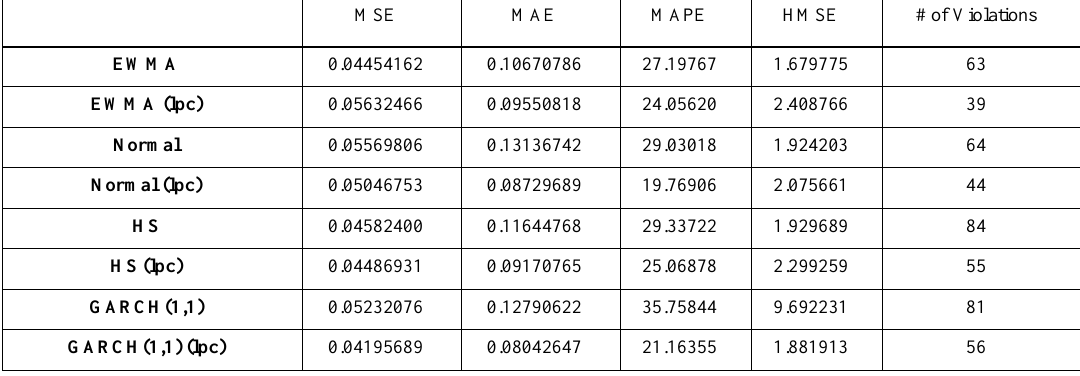
Table 4. Evaluation measures results for PVaR with and without lpc of NBG warrants – 2